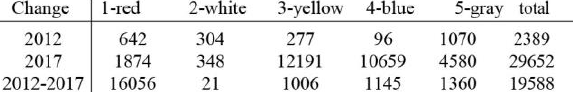
Table 1. Number of pixels changed for class and year